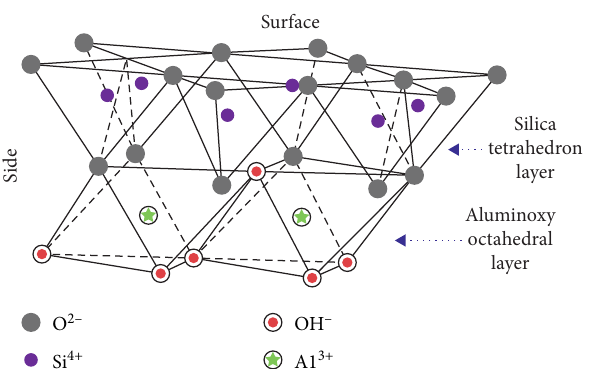
Figure 4: Basic structure unit of kaolin [21].